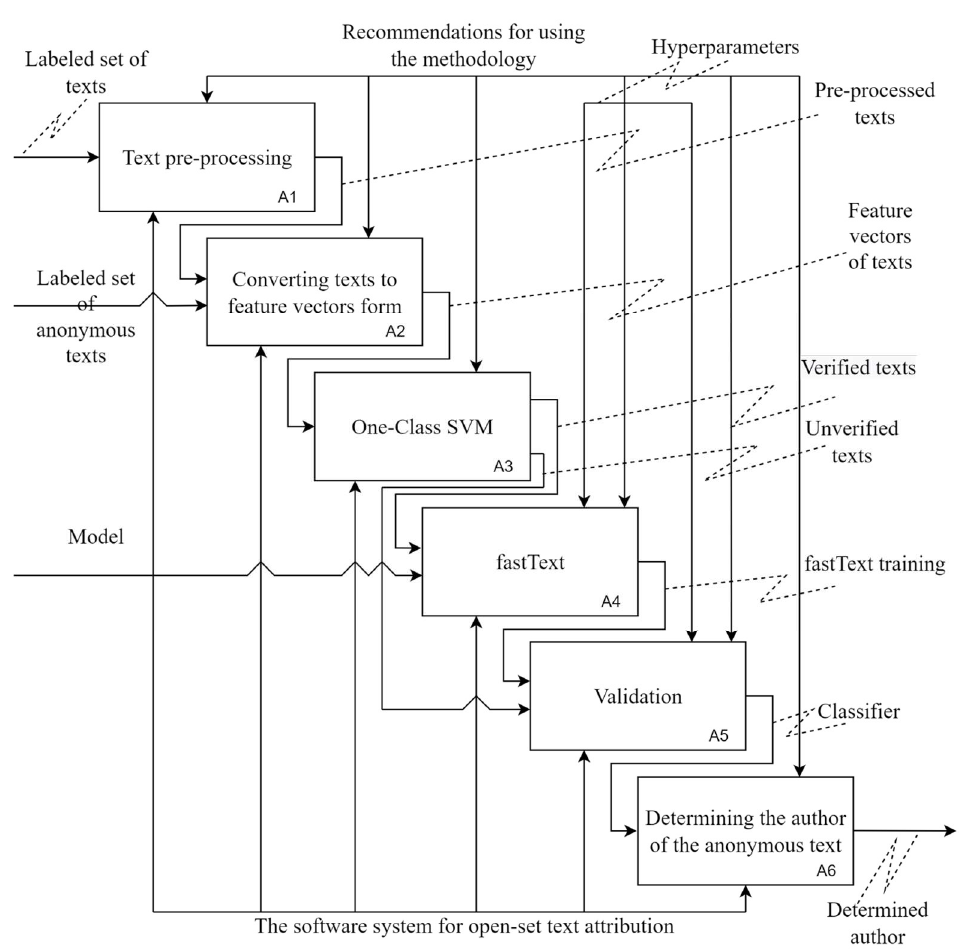
Figure 5. Open set IDEF0 diagram.